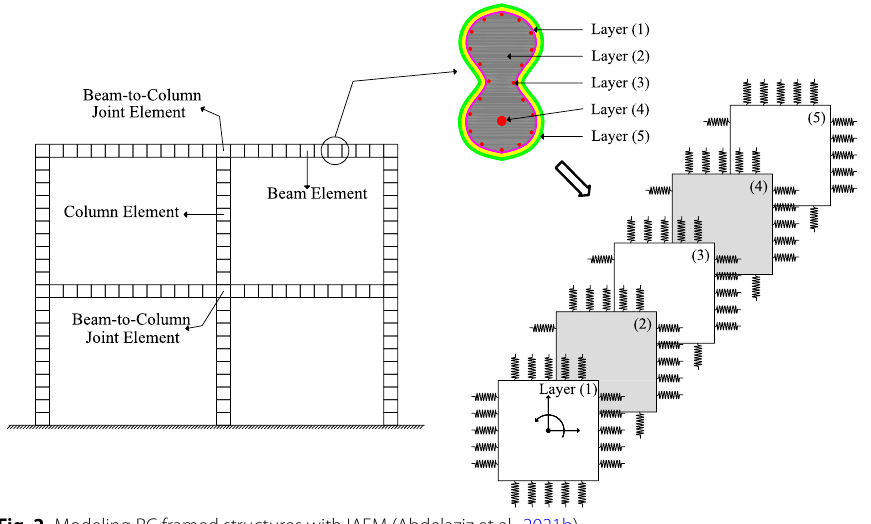
Fig. 2 Modeling RC framed structures with IAEM (Abdelaziz et al., 2021b)